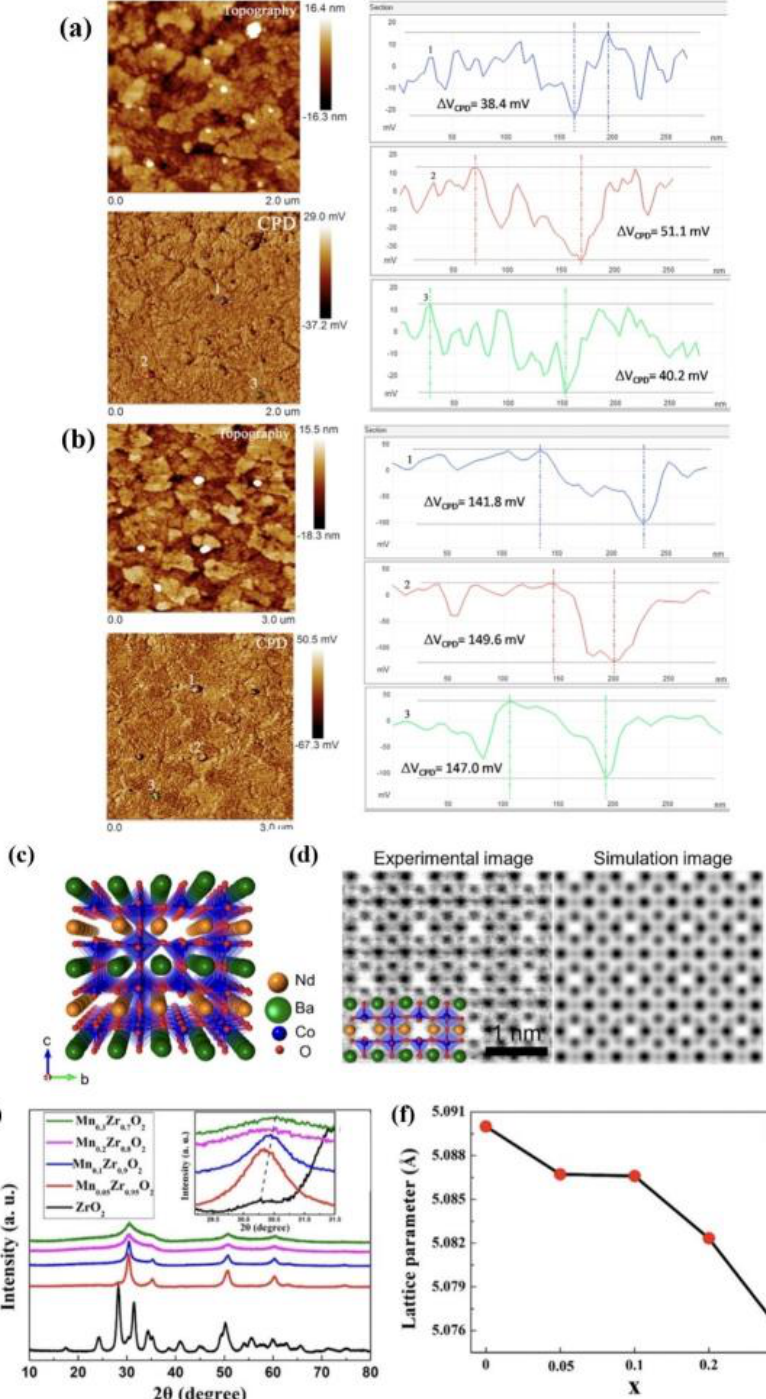
Figure 6. Topography and contact potential difference (CPD) images of as-prepared ( a ) BFO and ( b ) hydrogenated BFO (HB − 180 − 2 − 8) nanoparticles on ITO surface measured by KPFM. The cross − se − tional line profiles of CPD are achieved along the lines indicated by numbers 1, 2, and 3 in CPD images and direct observation of oxygen vacancy channels in NdBaCo 2 O 5.5 (NBCO 5.5 ) double perovskite. ( c ) Schematic view of the structure of NBCO 5.5 . ( d ) ADF STEM and simulated images of NBCO 5.5 taken in the [100] zone axis. ( e ) HAADF image of NBCO 5.5 with the EDS elemental map of Nd, Ba, and Co. ( f ) XRD patterns of MnxZr 1 − x O 2 catalysts [103 − 105].